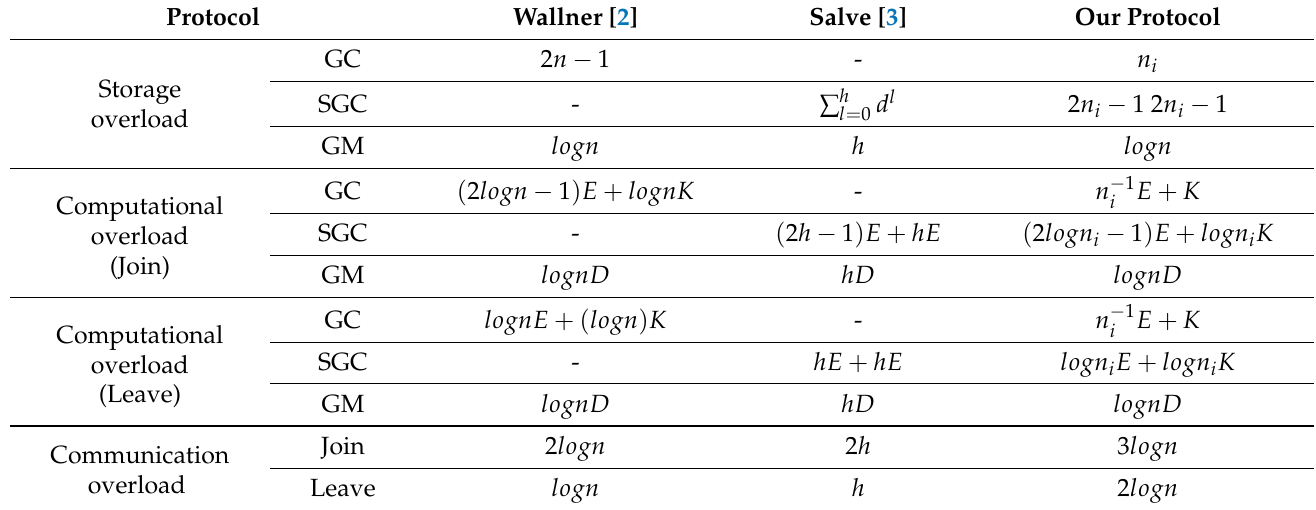
Table 2. Theoretical comparison with other